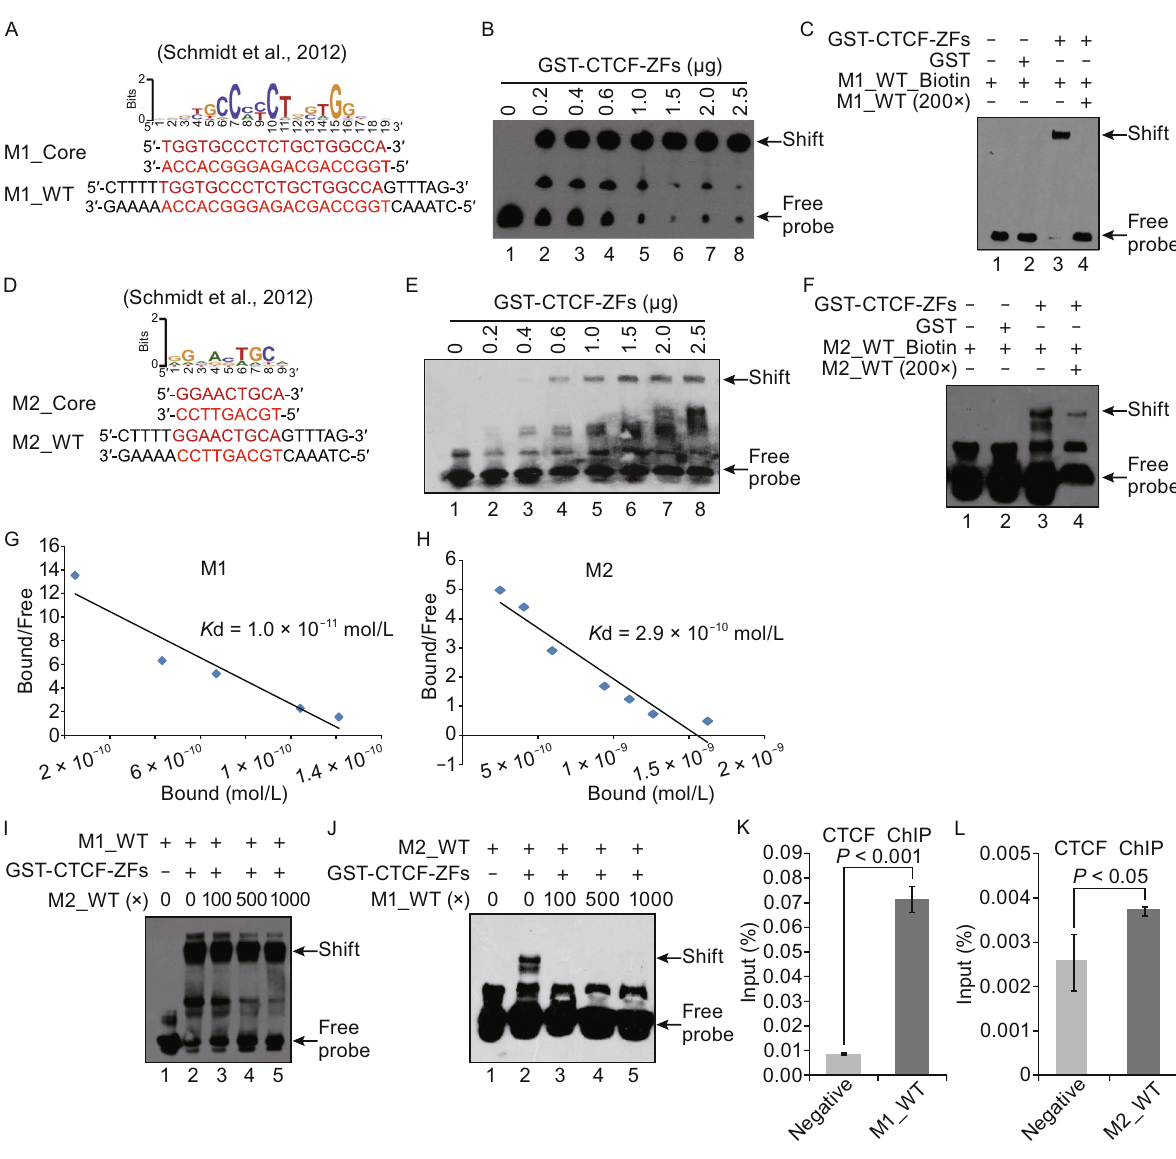
Figure 1. CTCF-ZFs bind to M1 stronger than to M2 . (A) The sequences of CTCF binding motif M1. (B) Gel mobility shift analyses between M1 motif and increased amount GST-CTCF-ZFs fusion protein. In a volume of 20 μ L, 20 fmol duplex probe was incubated with GST-CTCF-ZFs fusion protein with different amount (0, 0.2, 0.4, 0.6, 1.0, 1.5, 2.0, 2.5 μ g). (C) Gel mobility shift analyses of competition of GST-CTCF-ZFs binding to the biotin-labeled M1 by an excess amount of unlabeled M1. Lane 1. No protein; Lane 2. Incubation of GST with biotin-labeled M1 probe; Lane 3. Incubation of GST-CTCF-ZFs with biotin-labeled M1 probe; Lane 4. Incubation of GST-CTCF-ZFs with 20 fmol biotin-labeled M1 and 4 pmol unlabeled M1 probe. (D) The sequences of CTCF binding motif 2. (E) Gel mobility shift analysis of GST-CTCF-ZFs protein with M2 motif. Assay condition was the same as in Fig. 1B. (F) Gel mobility shift analysis of competition of GST-CTCF-ZFs binding to the biotin-labeled M2 by an excess amount of unlabeled M2. Assay condition was the same as in Fig. 1B. (G) Scatchard analysis of the gel shift binding of M1 to GST-CTCF-ZFs. The ratio of bound to (not clear) free DNA is plotted versus the molar concentration of bound M1 in the reaction mixture. (H) Scatchard analysis of the gel shift binding of M2 to GST-CTCF-ZFs. The ratio of bound to free DNA is plotted versus the molar concentration of bound M2 in the reaction mixture. (I) Competition assays of CTCF-ZFs binding to biotin-labeled M1 oligo with different amount of unlabeled M2 oligo. (J) Competition assays of CTCF-ZFs binding to biotin-labeled M2 oligo with different amount of unlabeled M1 oligo. (K) The binding level of CTCF protein to CTCF binding motif 1 (M1) was quantitatively measured by qPCR using the indicated primer sets. M1 enrichment was represented as percentage of input (%). (L) The binding level of CTCF to CTCF binding motif 2 (M2) was quantitatively measured by ChIP-qPCR using the indicated primer